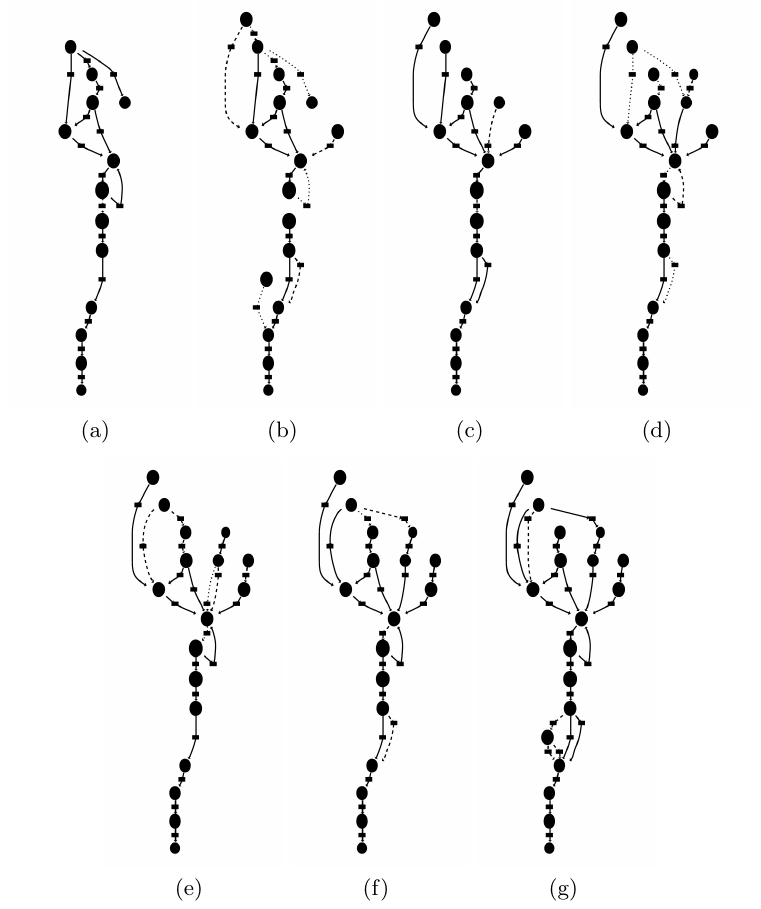
Fig. 5. Layouts of individual pathways obtained from a union graph layout in the computed order (from (a) to (f)). Appearing edges are shown dashed, disappearing edges